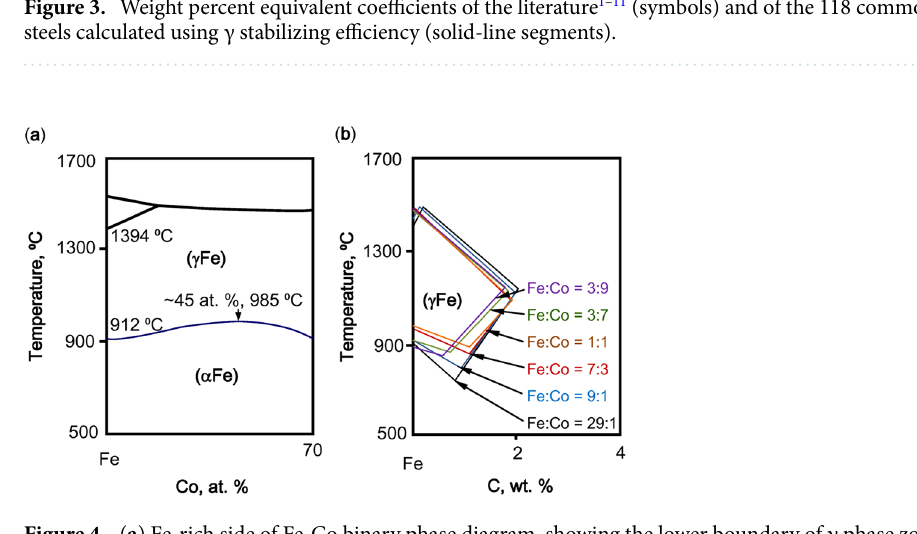
Figure 4. ( a ) Fe-rich side of Fe-Co binary phase diagram, showing the lower boundary of γ phase zone (blue line). ( b ) Fe-C-Co ternary phase diagram at a series of Fe:Co = 29:1, 9:1, 7:3, 1:1, 3:7, 3:9 (wt%), showing the gradual change of γ phase zone 29